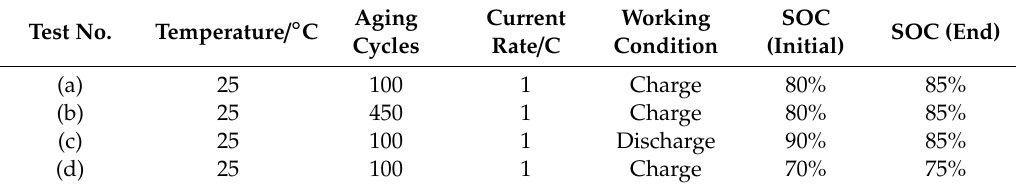
Table 1. Four pretests under di ff erent working conditions and